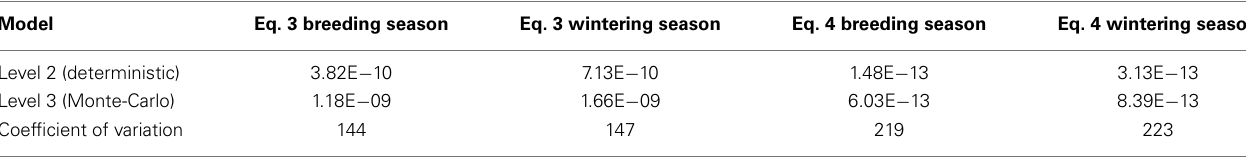
Table 2 | Differences in mean values across all cells for two modeling approaches (Level 2 and 3) and four transmission scenarios.